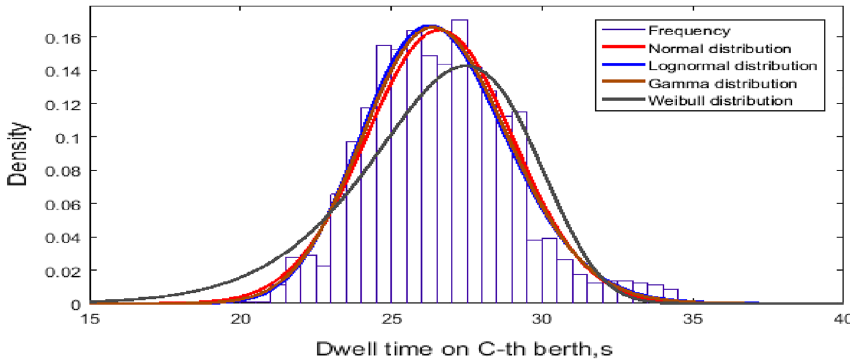
Figure 9. Dwell time at every berth.